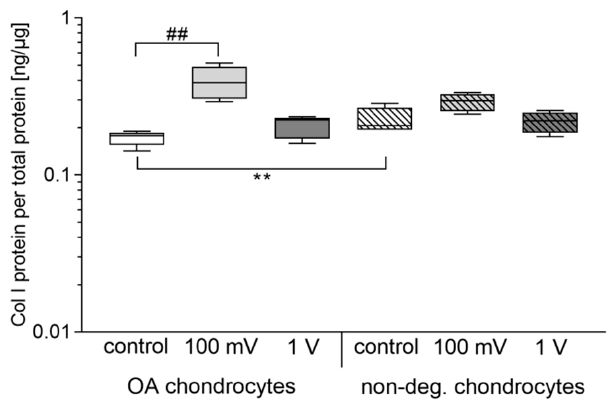
Figure 8. Collagen I release of human chondrocytes after electrical stimulation with 100 mV and 1 V at 1 kHz. Chondrocytes derived from non-degenerative ( n = 4) or osteoarthritic (OA) cartilage ( n = 6) were seeded on collagen scaffolds and stimulated over a period of seven days. Afterwards, protein biosynthesis of collagen I was detected in supernatants using the MicroVue CICP assay. Data are presented as boxplots. Statistical analysis within a stimulation group was performed with the Friedman test ( ## p < 0.01). To compare two samples between OA and non-degenerative chondrocytes Mann-Whitney-U-test was performed (** p < 0.01).